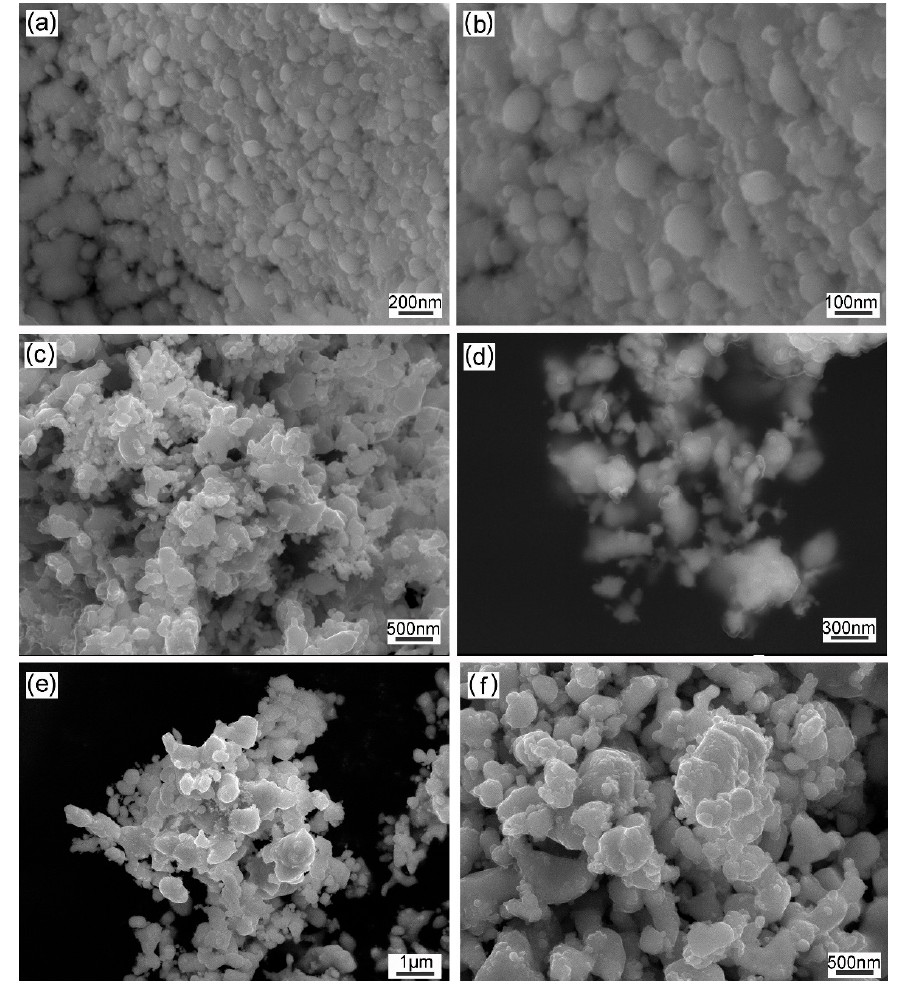
Figure 6. SEM images of the powder reduced at various temperatures of ( a , b ) 500 °C; ( c , d ) 700 °C; ( e , f ) 900 °C. ( e , f ) 900 ◦